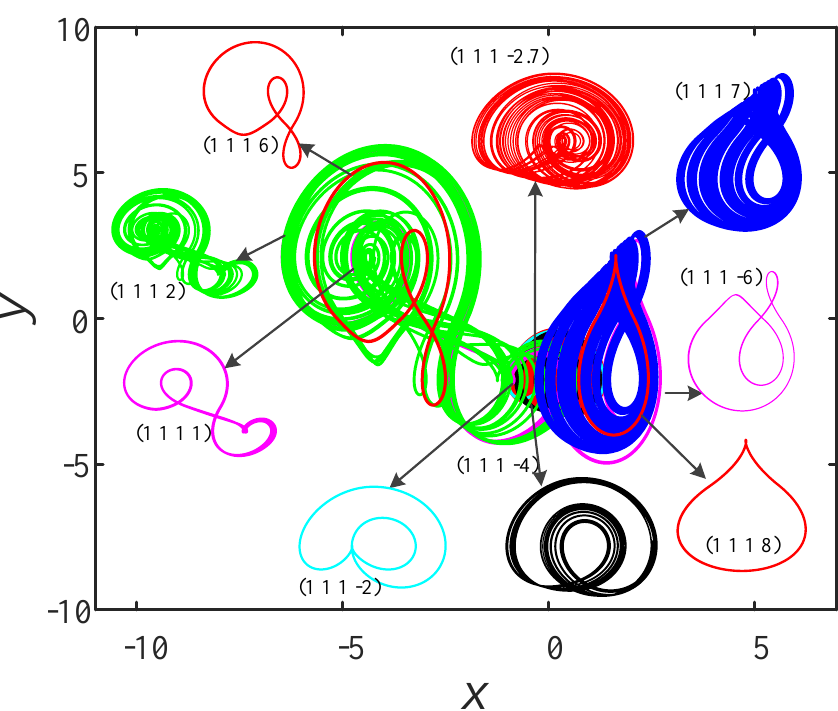
Figure 10. Multiple coexisting attractors with different initial values.